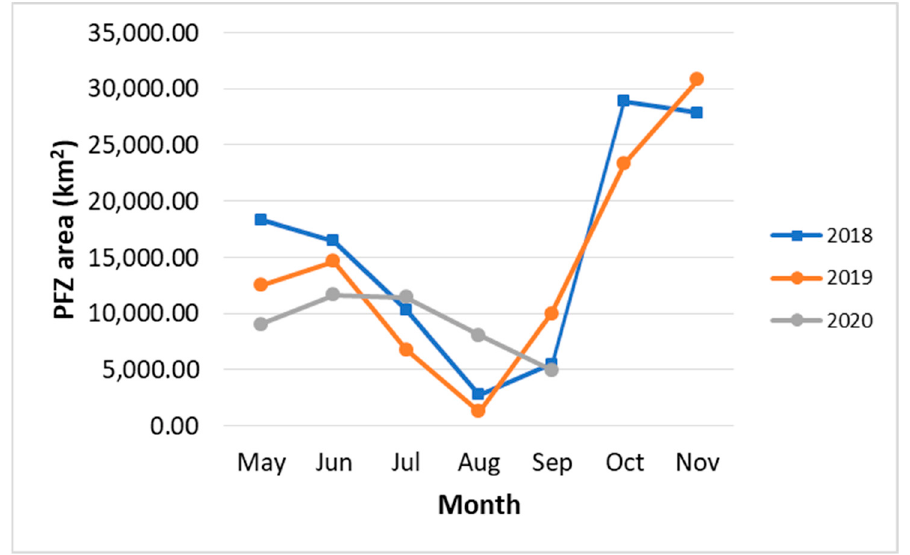
Figure 9. Monthly variations in PFZ area for Sardinella aurita during 2018–2020.